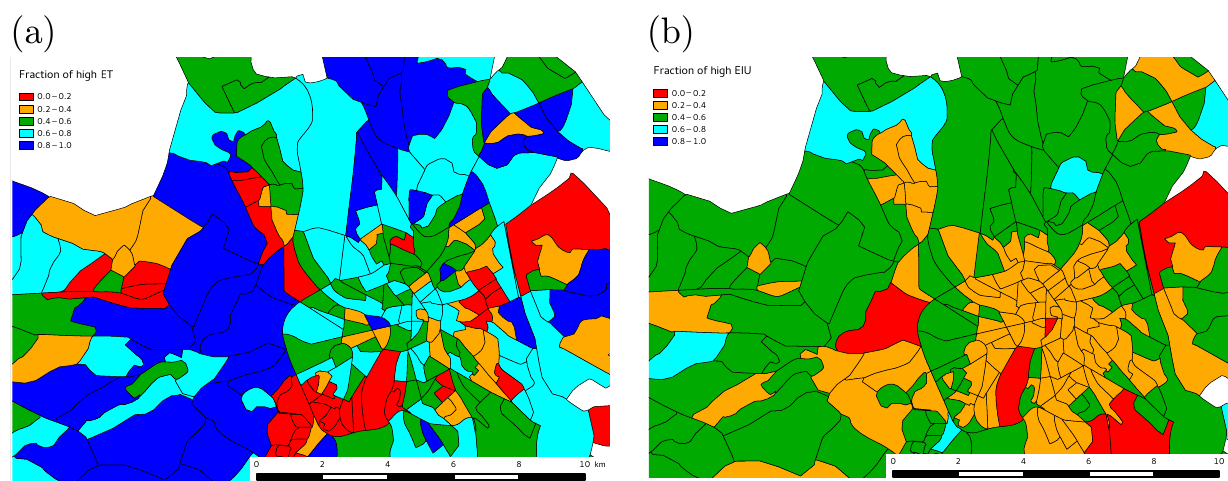
Figure 4. Spatial distribution in the agglomeration Toulouse of (a) fraction of households with high efficiency tendency (ET) and (b) fraction of households with high equipment-intensity-of-use (EIU). The spatial variability is introduced by the predictors of the statistical models described in Bourgeois et al. (2017). These are the heating system type (collective/individual), the type of fuel used in the heating system, and the age of the inhabitants for ET and the number of inhabitants per habitable floor area for